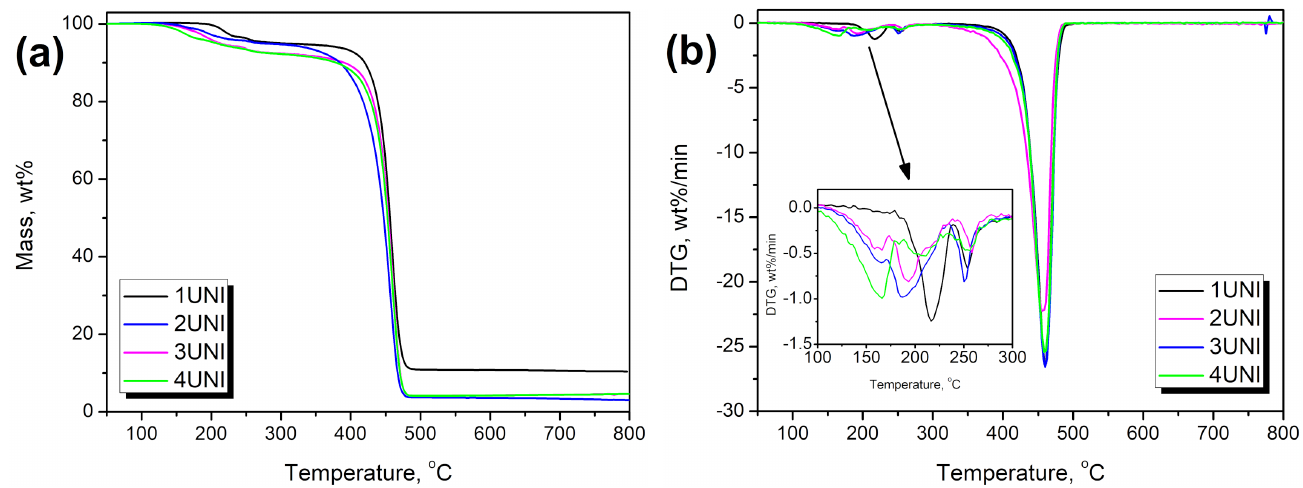
Figure 12. The impact of PUR foam content on the course of thermal degradation of samples modified with the UNI blowing agent. ( a ) mass loss curves, and ( b ) differential thermogravimetric curves.